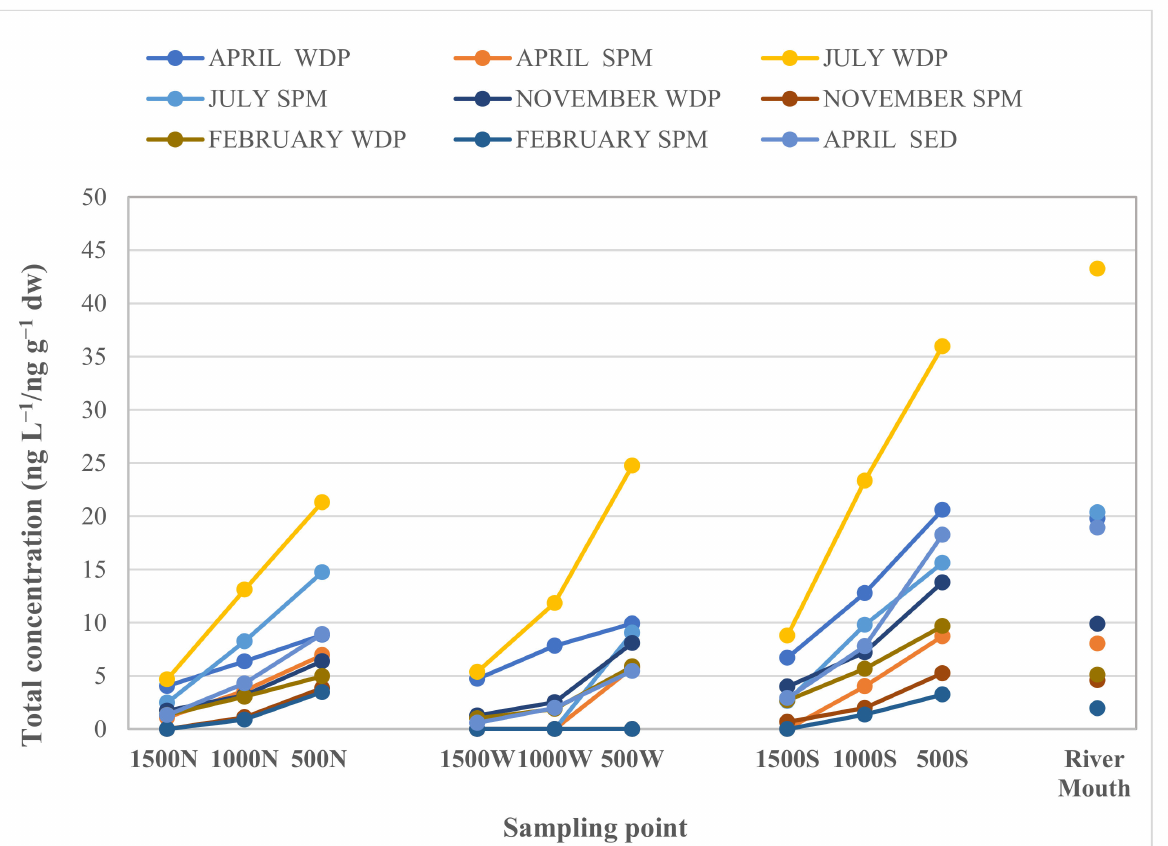
Figure 3. Spatial and temporal concentration of OPPs in the water dissolved phase (WDP, ng L − 1 ), suspended particulate matter (SPM, ng L − 1 ) and sediments (SED, ng g − 1 dry wt) of the Sele River, Southern Italy in 10 sampling sites (river mouth; 500N: nord estuary at 500 m; 1000N: nord estuary at 1000 m; 1500N: nord estuary at 1500 m; 500W: west estuary at 500 m; 1000W: west estuary at 1000 m; 1500W: west estuary at 1500 m; 500S: south estuary at 500 m; 1000S: south estuary at 1000 m; and 1500S: south estuary at 1500